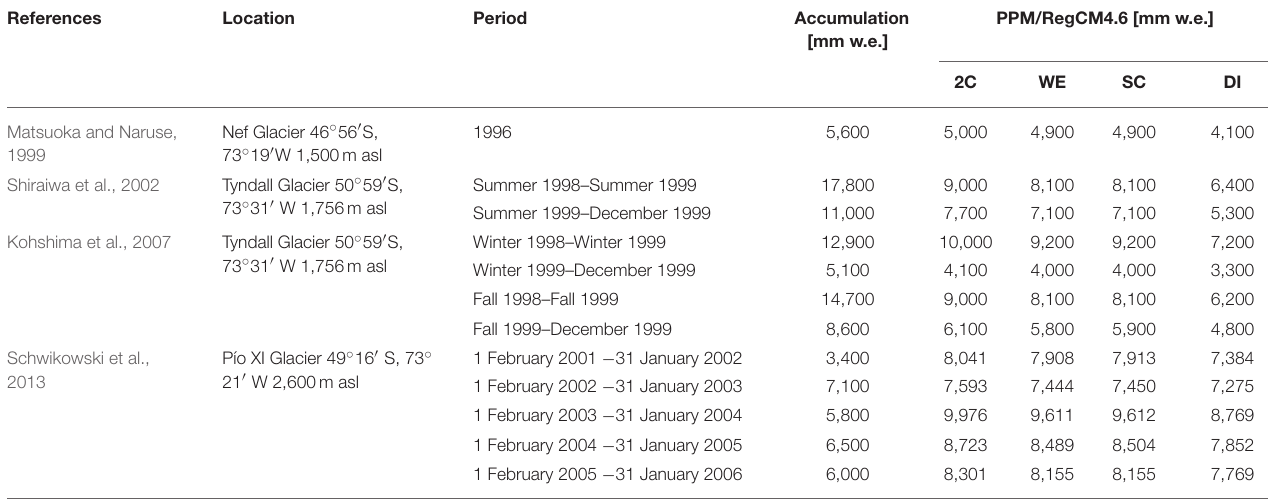
TABLE 3 | Comparison of previous snow accumulation estimates using ice core data with the snow accumulation obtained in this